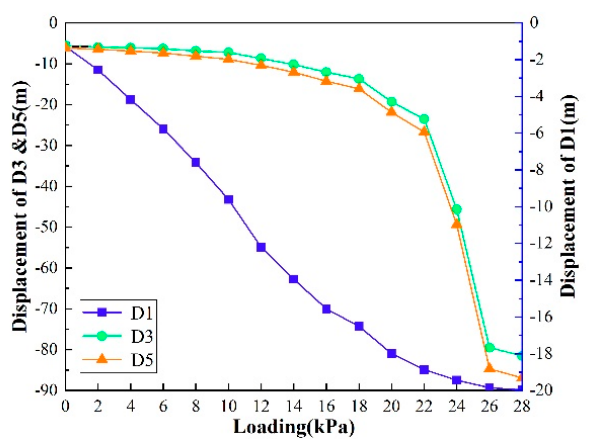
Figure 11. Displacement change view of D1, D3, and D5.